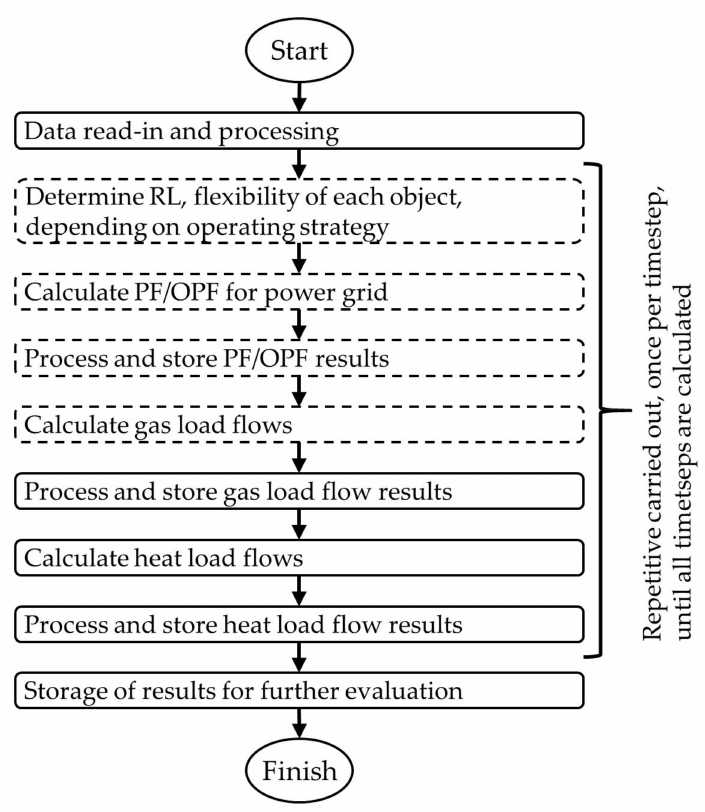
Figure 5. Overview of the calculation